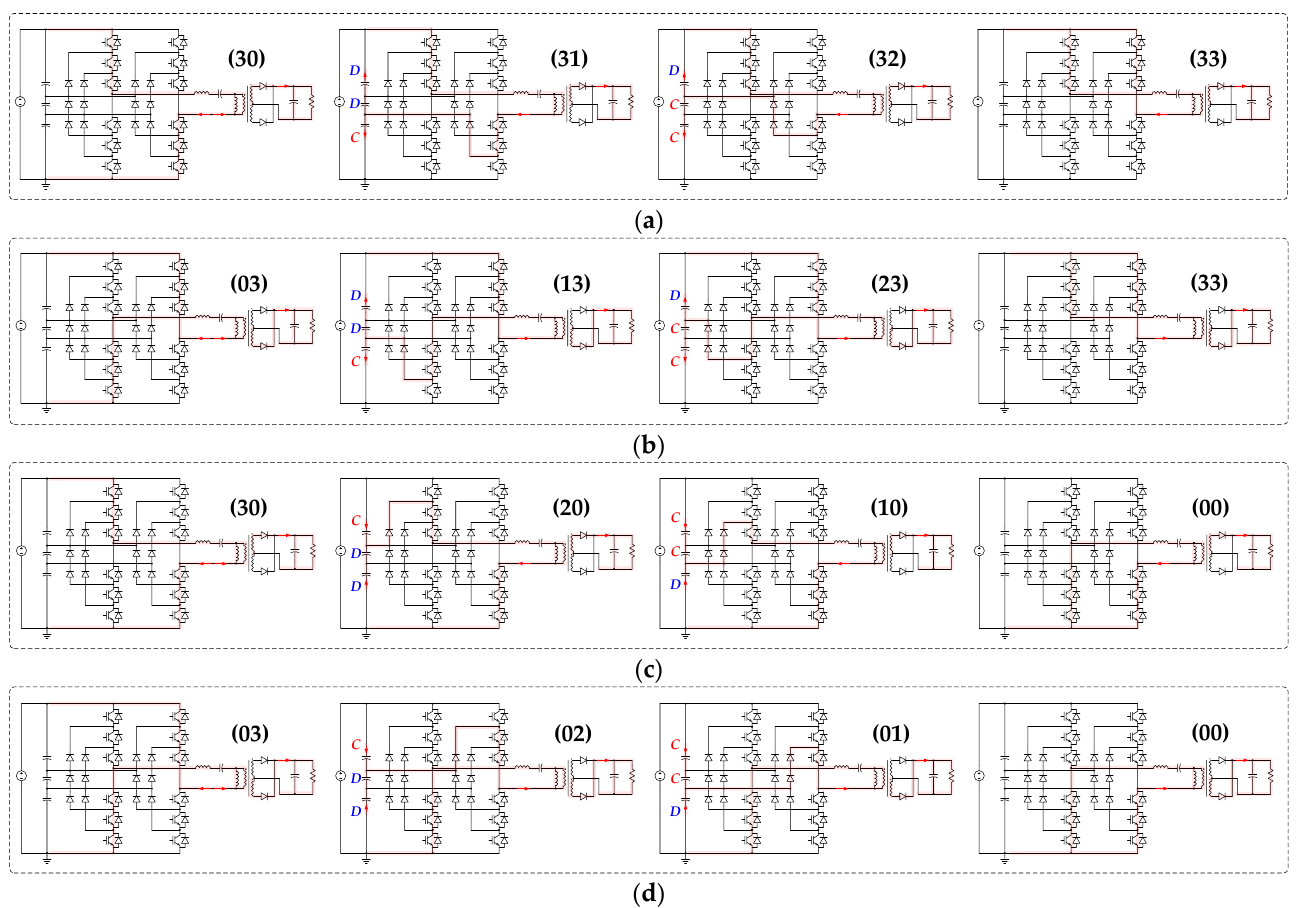
Figure 7. Operating circuit states when ( a ) V C* > 0 and ( b ) V C* < 0 in the UCM and when ( c ) V C* > 0 and ( d ) V C* < 0 in the LCM.